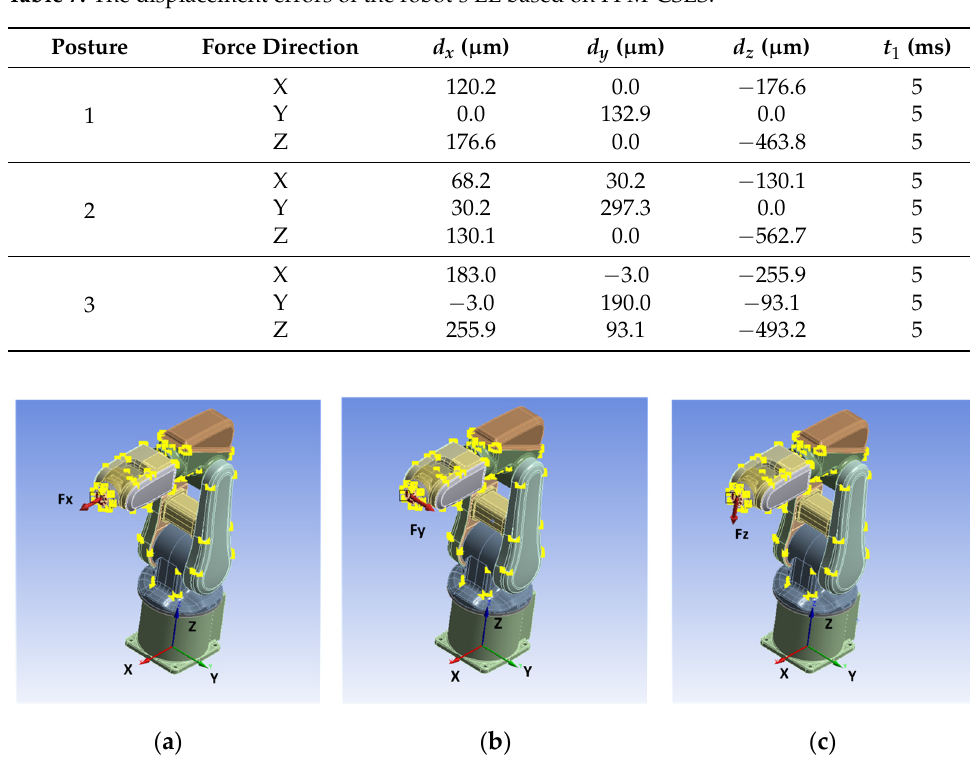
Table 7. The displacement errors of the robot’s EE based on FPM-CSES.